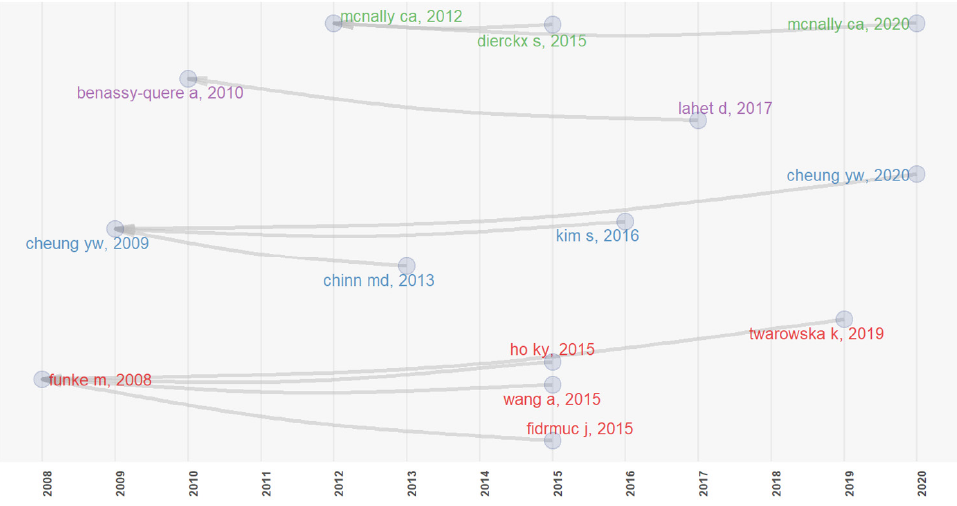
Figure 13. Historiograph (by paper). Source: Authors’ elaboration using Biblioshiny. In our dataset, the average number of global citation scores (GCS) is 6.1 with a stand- ard deviation of 12.6 and a median of 2, indicating that 95% of the values are less than 19.1 and 1% of the values are more than 31.7.